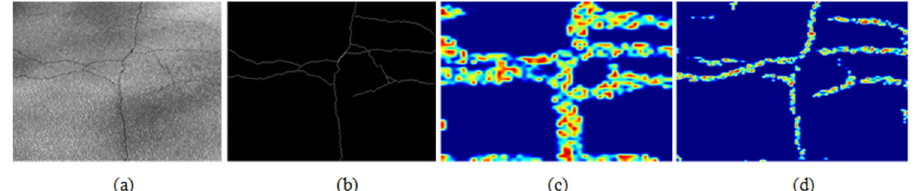
Figure 5. Structural diagram of the morphological network.